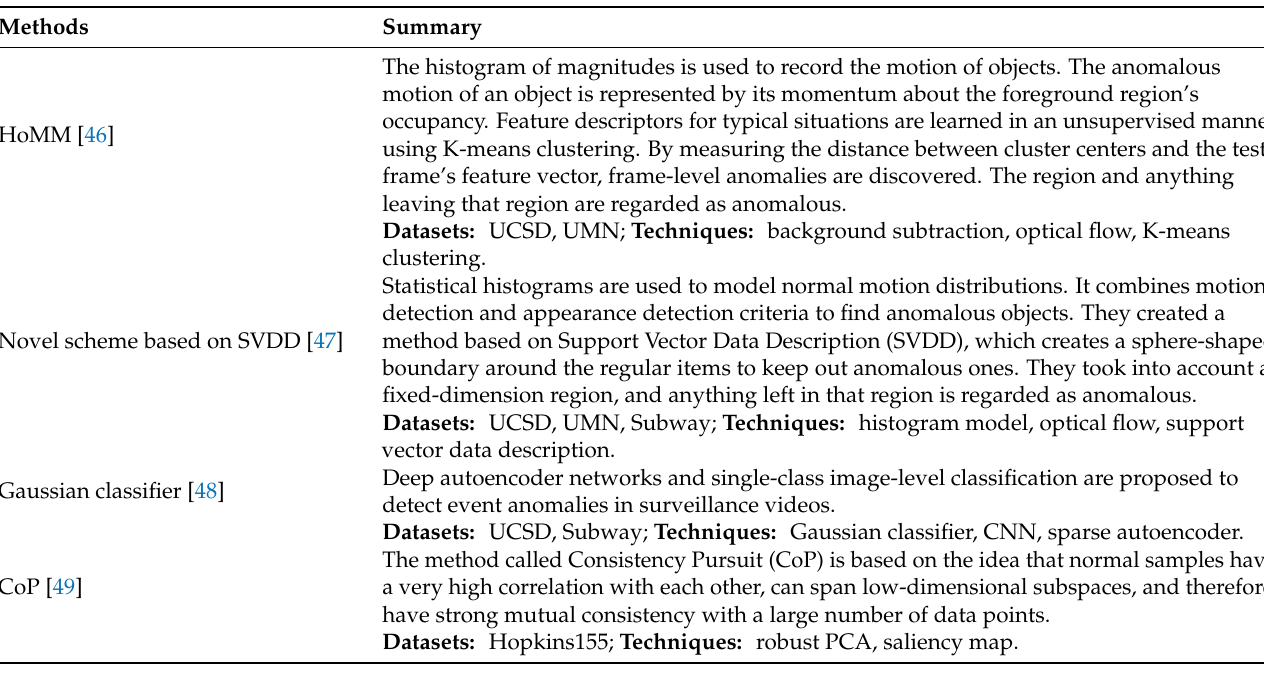
Table 2. Statistics-based